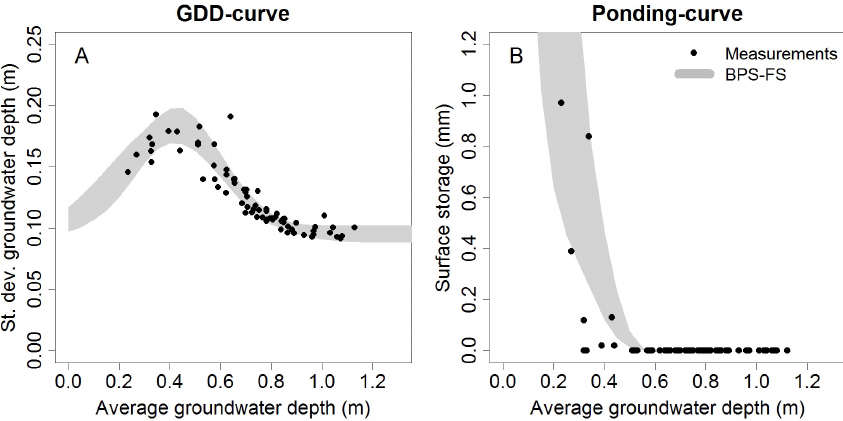
Fig. 4. Measured and simulated groundwater depth distribution curve (GDD-curve) (A) and Ponding curve (B) of the field-site. The grey area represents the ensemble of behavioral parameter sets of the field-site model